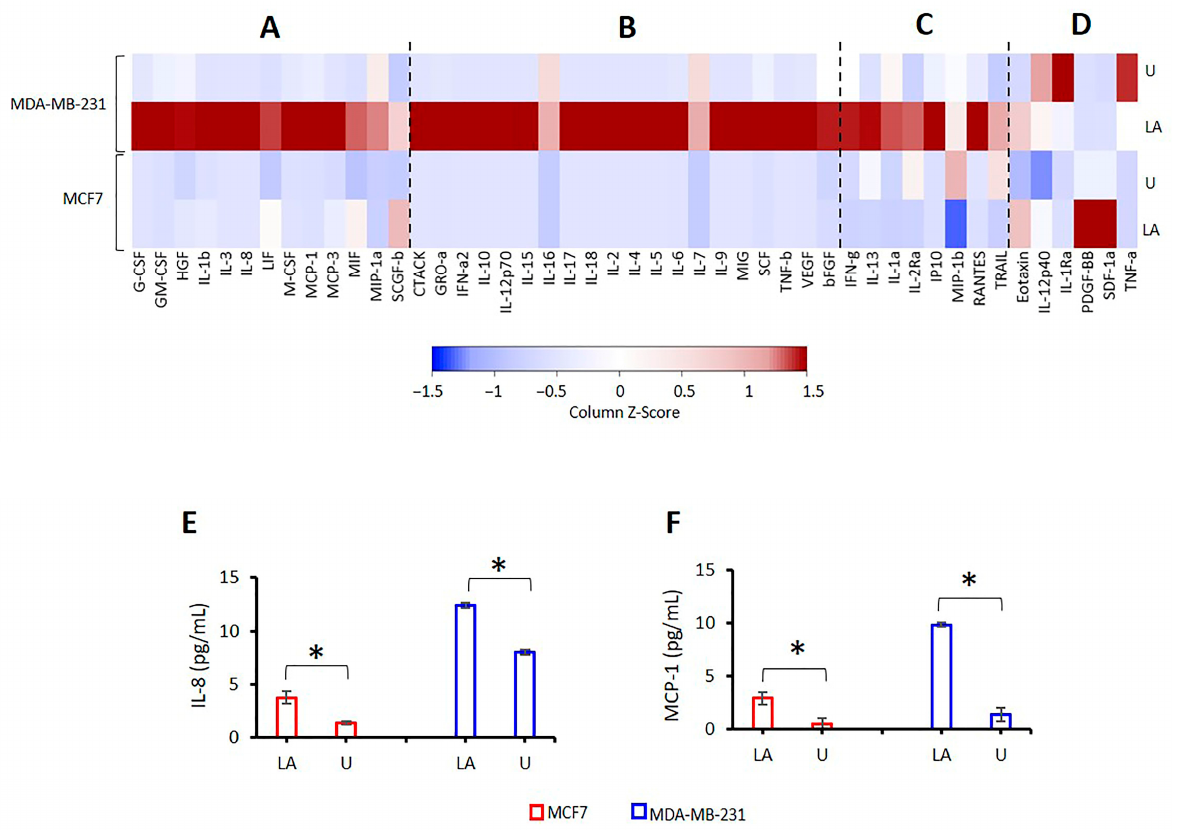
Figure 6. The heat map analysis of cytokine secretion in MDA ‐ MB ‐ 231 and MCF ‐ 7 cells after NLRP3 activation. After inflammasome activation, cytokine secretion in MDA ‐ MB 231 and MCF7 cells was analyzed using Bio ‐ Plex Pro Cytokine Screening Panel. Results were calculated with BioPlex Man ‐ ager v.6.1. A minimum of 50 beads per well for each cytokine were analyzed. ( A ) Cytokines released by MDA ‐ MB ‐ 321 and MCF7 cells; ( B ) cytokines activated only in MDA ‐ MB ‐ 231; ( C ) cytokines acti ‐ vated in MDA ‐ MB ‐ 231 but decreased in MCF7; ( D ) cytokines decreased in MDA ‐ MB ‐ 231 but unaf ‐ detection of MCP ‐ 1 release in MCF7 and MDA ‐ MB ‐ 231 cells. p value was calculated using